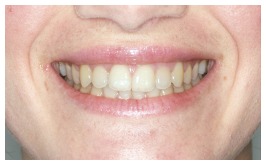
Original photograph.